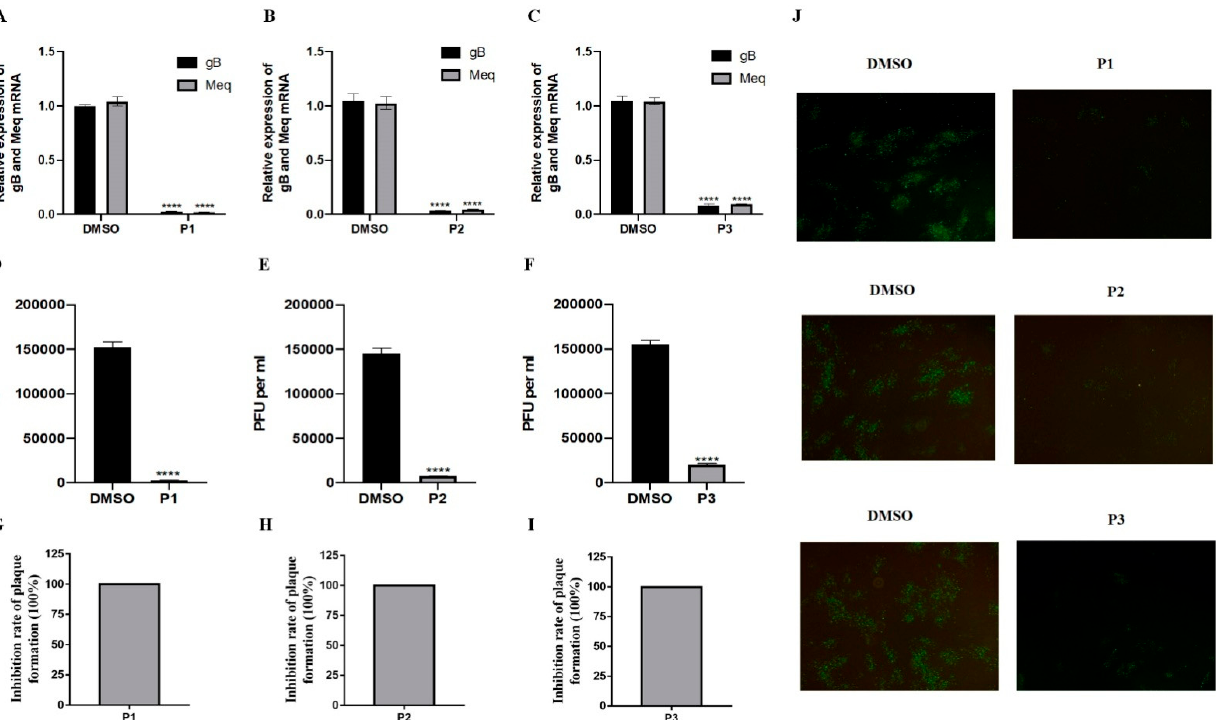
Figure 3. LiCl has an inhibitory effect in all stages of MDV infection. ( A – C ). The gene expression levels of Meq and gB were detected by RT-qPCR. The DMSO treated group was used as control. ( D – F ). Quantification of the virus by plaque counting. ( G – I ). The inhibition rate of plaque was calculated and presented as mean plaque titers relative to the DMSO group. The mean plaque titer of the DMSO group was set to 100%. ( J ). Detection of the inhibitory effect of LiCl on MDV RB-1B replication by indirect immunofluorescence assay. P1: cells were pretreated with 20 mM LiCl for 2 h before virus inoculation, P2: 20 mM LiCl and virus infected cells were added at the same time, and P3: 20 mM LiCl was added after virus inoculation. The pictures were captured with an OLYMPUS microscope (×200). The data are expressed as the av- erage ± SD of three independent experiments, and analyzed by Student-t Test (**** p < 0.0001) for A and C.